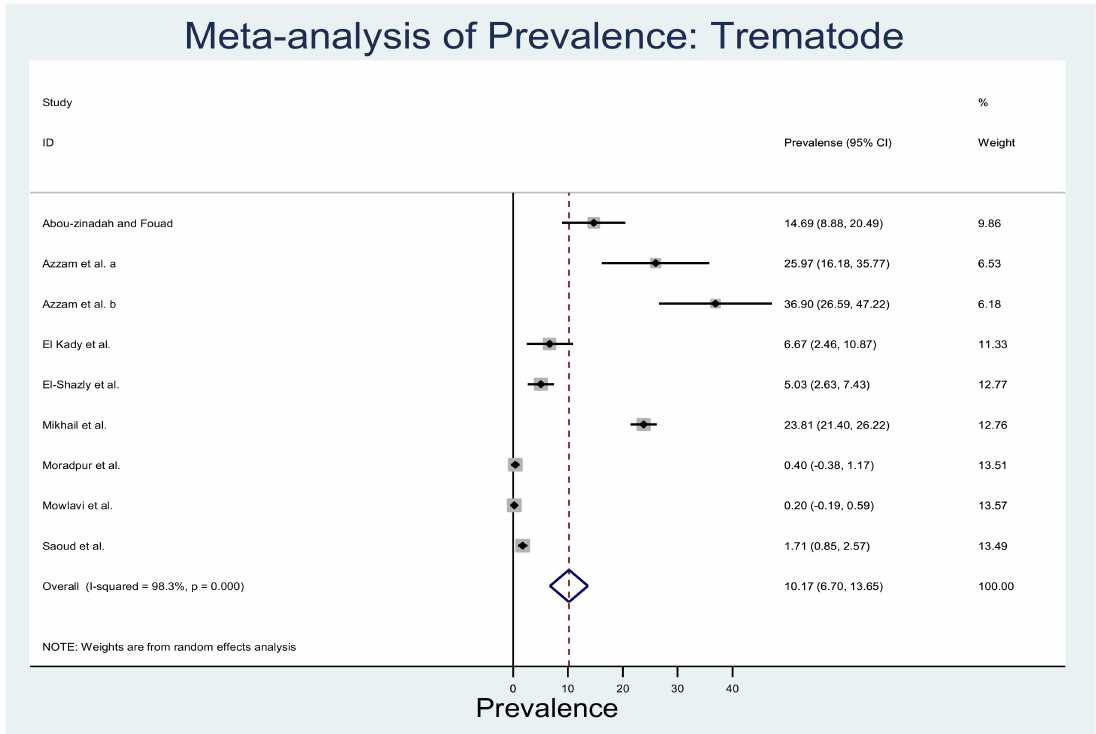
Figure 5. Forest plot of the prevalence estimates of trematode in rodents among the Middle East countries (the center dot representing point estimates, whereas Gray Square representing the weight of each study to the meta-analysis).